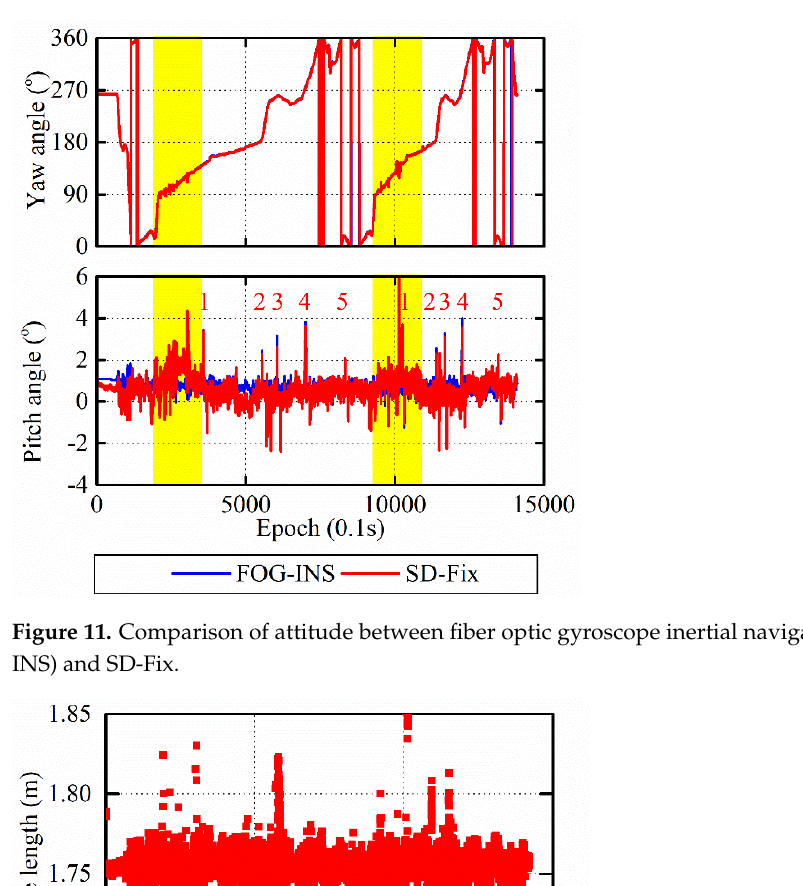
Table 5. RMSEs of attitude angles for SD-Fix with common clock /° .